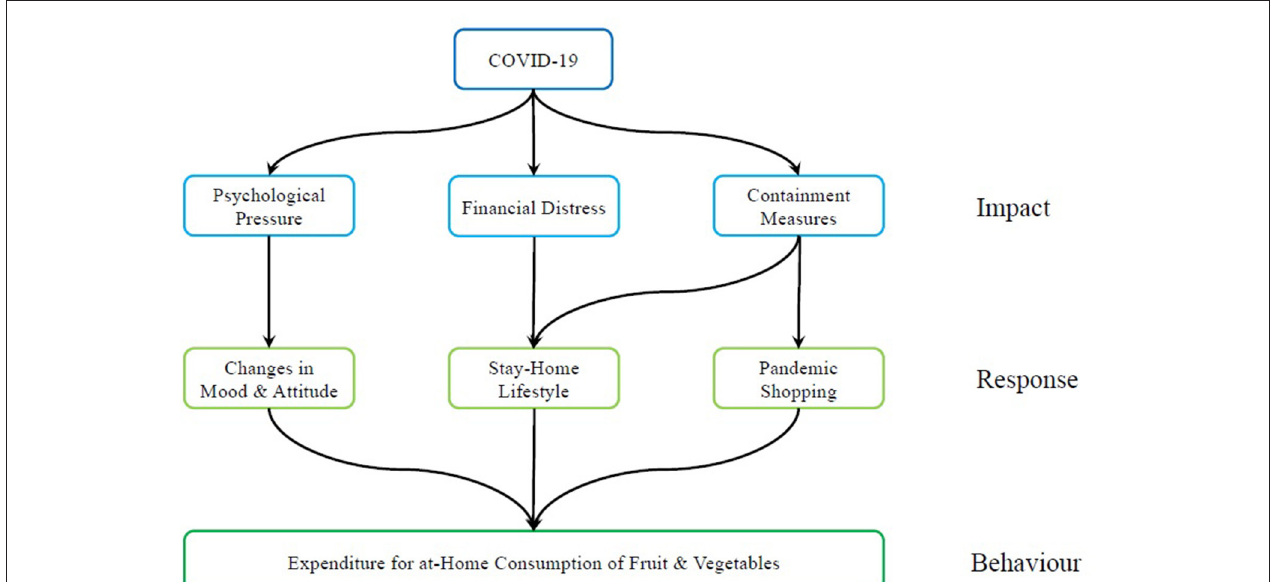
FIGURE 1 | Impact-response